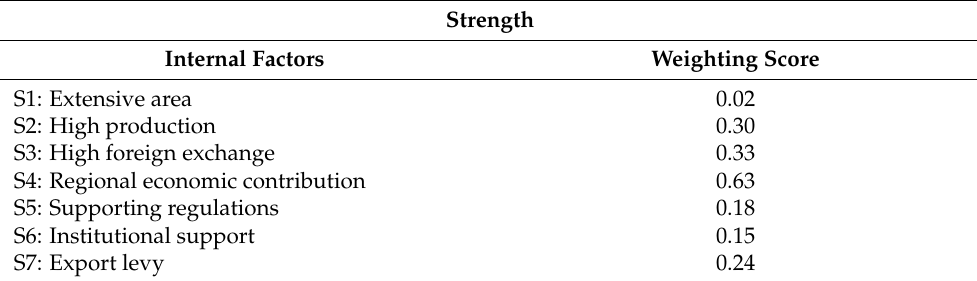
Table 4. Strength factors supporting the adoption of DBH